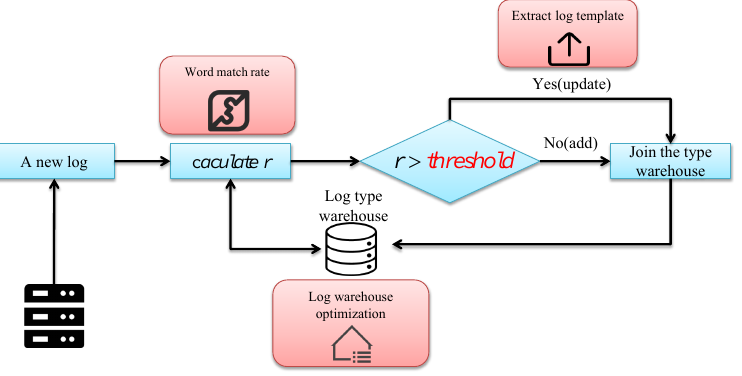
Figure 1. The Flow Chart of Online log